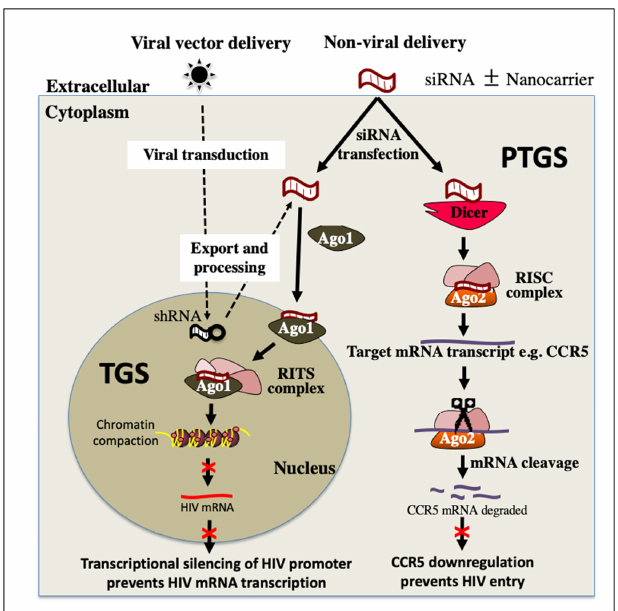
Figure 4. Proposed combination of PTGS and TGS RNAi pathways to control HIV infection. Both RNAi pathways can be mediated by viral or non-viral delivery of RNA sequences. siRNA can achieve PTGS via RISC initiating specific cleavage of mRNA transcripts of cellular factors required for HIV infection or replication such as CCR5. A downregulation of CCR5 prevents entry of HIV into the cell. siRNA can also trigger TGS in the nucleus via the RITS complex. This initiates repres- sive epigenetic modifications, such as increased histone methylation and deacetylation, at the HIV promoter region, resulting in transcriptional silencing and abrogation of the replication cycle. PTGS, post-transcriptional gene silencing; TGS, transcriptional gene silencing; Ago1, Argonaute 1; Ago2,